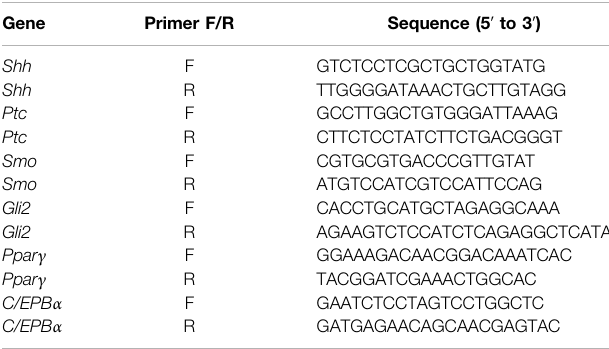
TABLE 1 | Nucleotide sequences of the